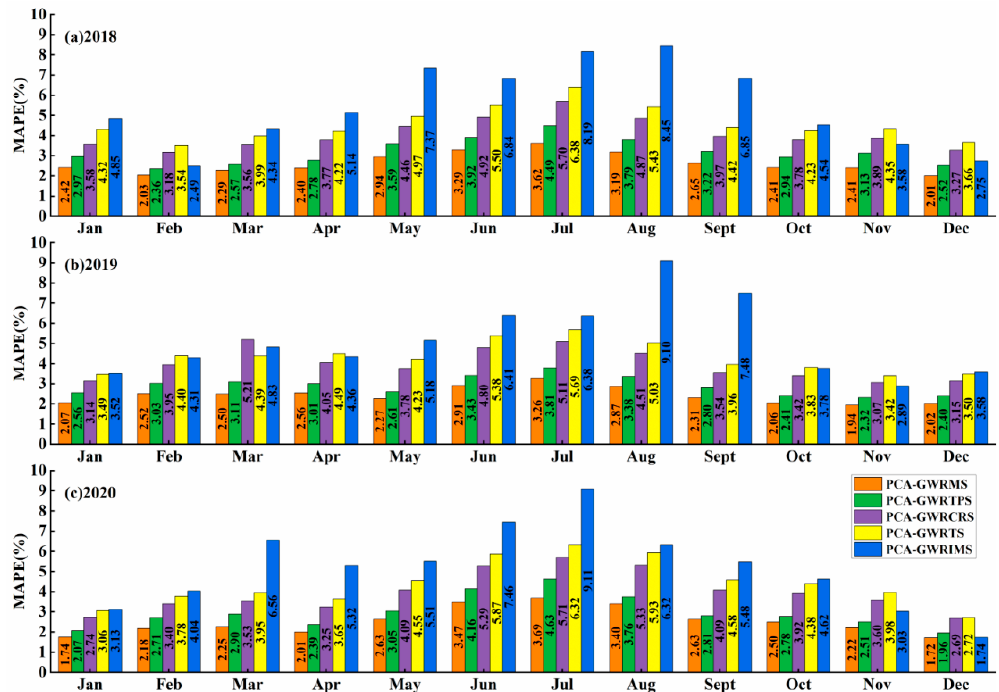
Figure 10. MAPE of cross-validation results after the residual correction of PM 2.5 estimates from PCA-GWR models for different months in ( a ) 2018, ( b ) 2019 and ( c ) 2020 using five interpolation methods (MS (orange), TPS (green), CRS (purple), TS (yellow), and IMS (blue)).